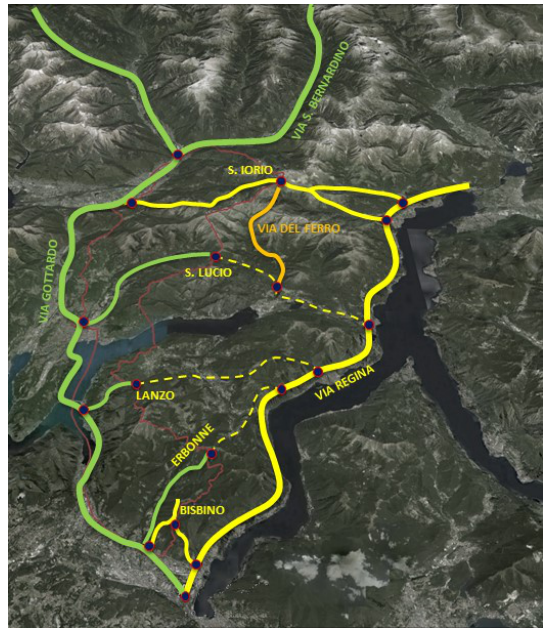
Figure 2. The area covered by the Via Regina